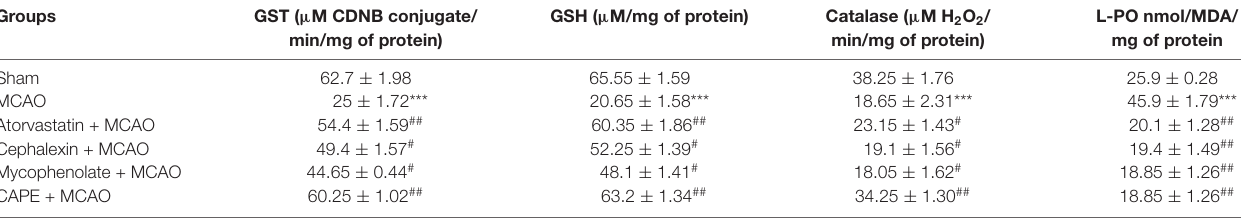
TABLE 4 | Effect of atorvastatin, mycophenolate, cephalexin, and CAPE on oxidative enzymes in the cortex. Groups